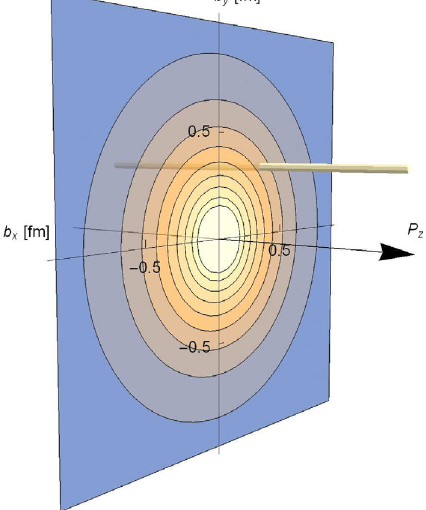
Fig. 10 Density plot of the two-dimensional energy density ρ( b ⊥ ) using the multipole model (11) with parameters given in Table 1, see Eq. (56) or Eq. (61) for the definition in terms of GFFs. The cylinder parallel to P = P z e z illustrates the integration over r (cid:13) , see Eq.